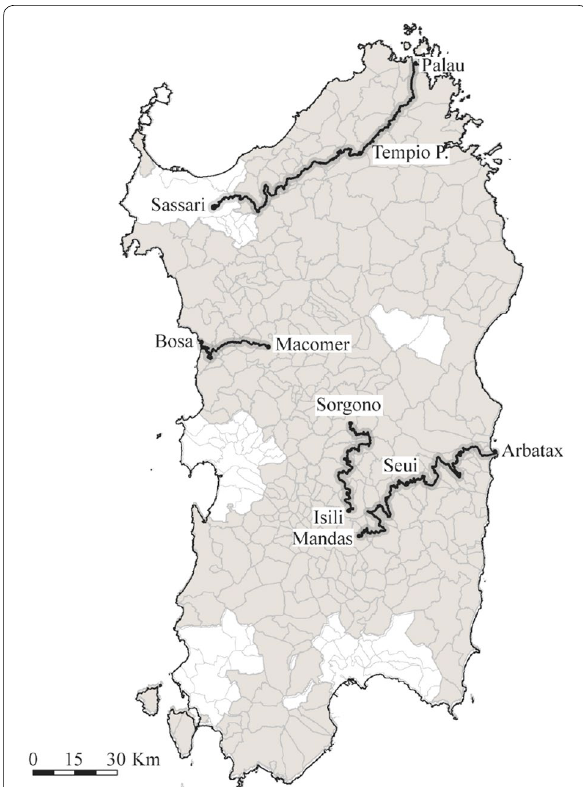
Fig. 4 Map of historical railways, Trenino Verde (in black). In grey, the municipalities classified “inner areas” (Source: Tracks from http://www. treni nover de.com/)